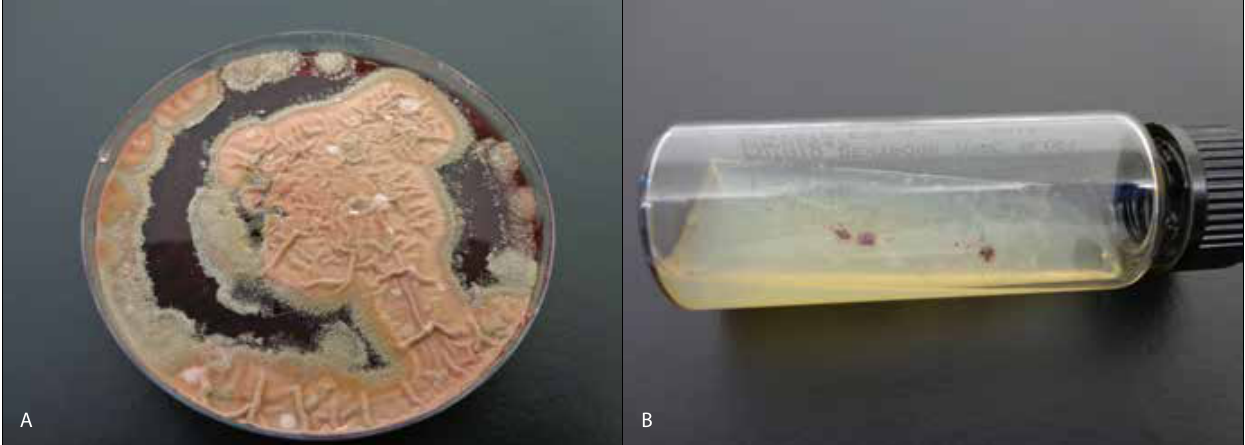
Fig. 1. Mould phase of Talaromyces (Penicillium) marneffei on Sabouraud agar (A), and yeast phase of Talaromyces (Penicillium) marneffei on brain-heart infusion agar (pale-cream mucoid colonies)